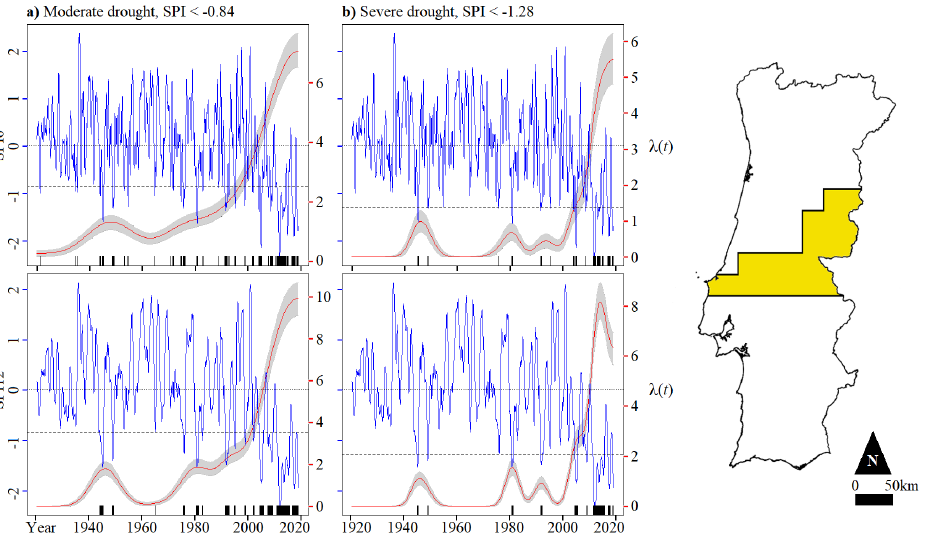
Figure 10. Transitional region. Time dependent occurrence rates, λ ( t ) (year − 1 ), in red, and confidence band in grey of ( a ) moderate and ( b ) severe droughts for SPI6 and SPI12 in blue. The horizontal- dashed lines different to zero represent the drought thresholds and vertical ticks, with SPI below